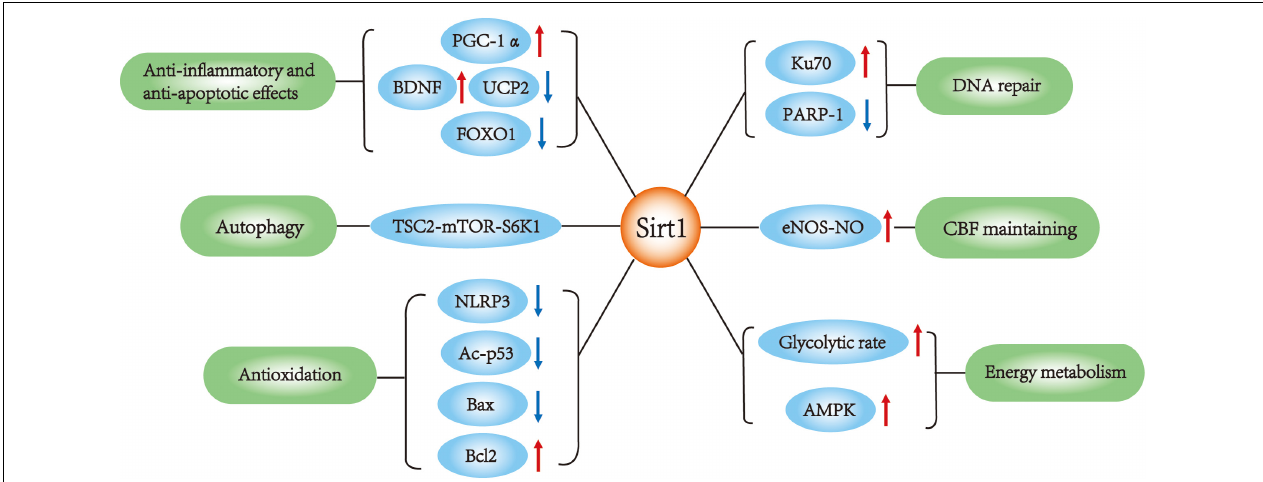
FIGURE 1 | Sirt1 main functions in ischemic stroke. SIRT1 interacts with multiple targets in ischemic stroke, which is involved in the regulation of apoptosis, autophagy, DNA repair, inflammation, metabolism and oxidative stress, cerebral blood